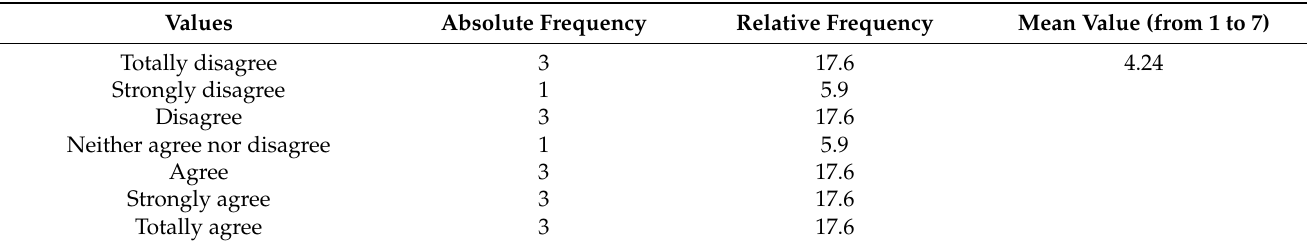
Table 10. Analysis of the results for item 10: “Reconciliation of work–life balance would not remove barriers faced by female